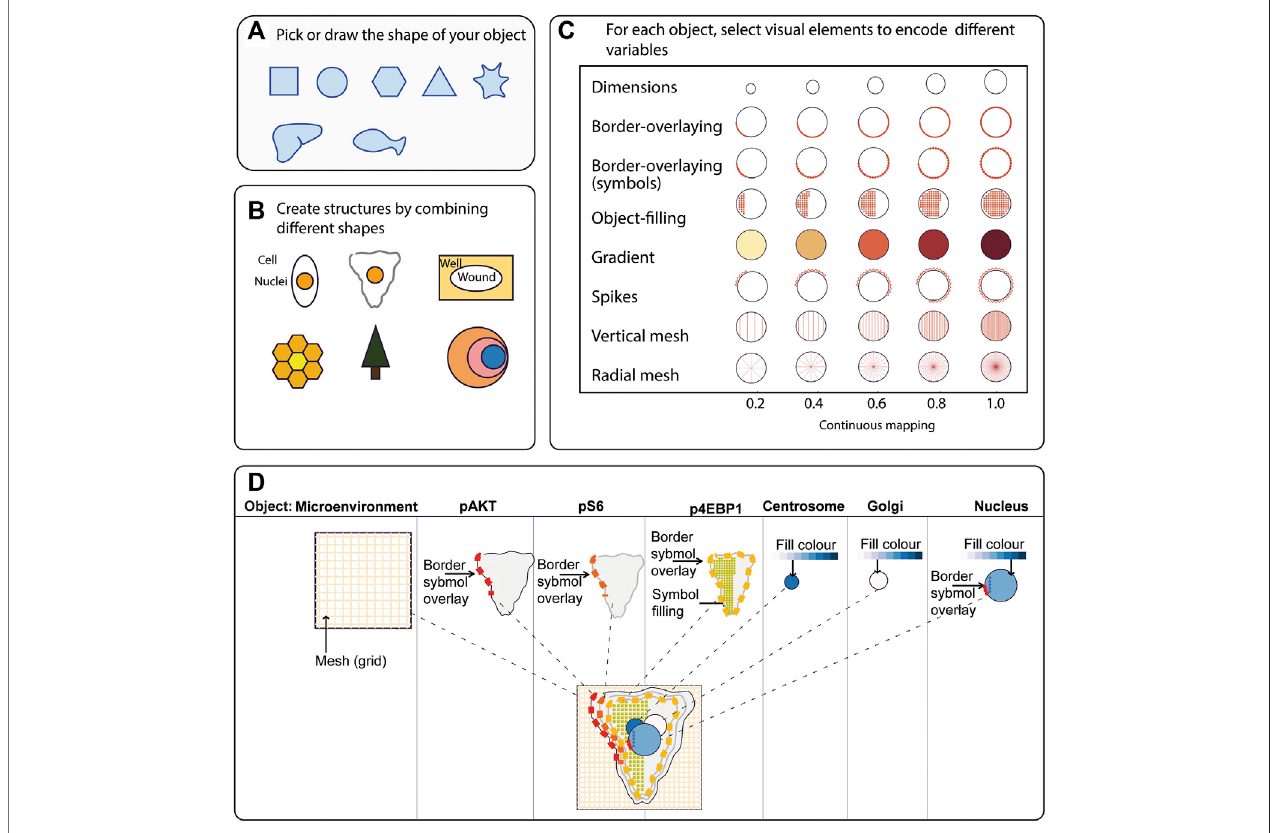
FIGURE 1 | ShapoGraphy provides a highly fl exible framework for creating glyph-based visualisations. (A) Example of object shapes that can be created using Shapography. (B) Shapes can be combined to create structures that resemble the measured phenomena. (C) Various visual elements are de fi ned for each object and can be selected by the user to encode several variables. (D) An example of how objects can be combined to represent a wide range of phenotypic